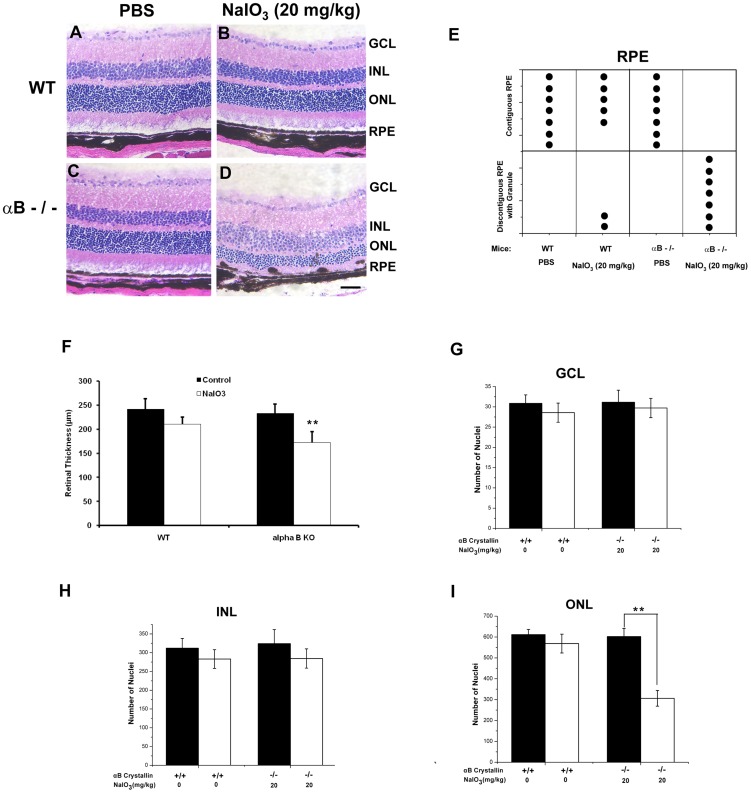
Histopathology of retina from control and NaIO3-treated αB crystallin knockout (αB-/-) mice.Three weeks after tail vein injection of 20/kg NaIO3, eyes were enucleated and frozen sections were stained with H&E. The four experimental groups of mice were PBS-treated WT (A), NaIO3-treated WT (B), PBS-treated αB-/- (C), and NaIO3-treated αB-/- (D). The RPE layer in αB-/- mice with NaIO3 injection were discontiguous and damaged. Only two out of seven WT mice showed discontiguous and damaged RPE (E). Bar graph showing retinal thickness (µm) with and without NaIO3 in WT and αB-/- mice. (F). Retinal thickness was significantly lower (P<0.01) in NaIO3 treated αB-/- mice when compared to the corresponding WT group. No significant differences in the number of nuclei in the ganglion cell layer, outer nuclear layer or inner nuclear layer were found between the NaIO3-injected and PBS-injected WT mice (G–H). The number of nuclei per unit area in the outer nuclear layer of NaIO3 injected αB-/- mice showed a significant decrease (P<0.01) as compared to control without NaIO3 injection (I). RPE: RPE cell layer; ONL: outer nuclear layer; INL: inner nuclear layer; GCL: ganglion cell layer. Data are mean ± SEM, n = 7/group, **P<0.01. Bar equals 75 µm.